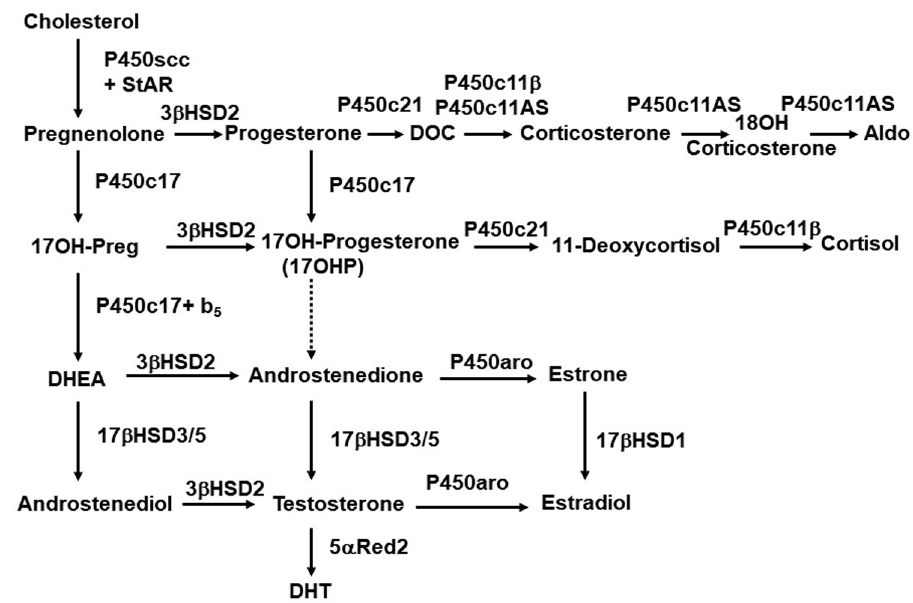
Fig 1. The “conventional” pathway of steroidogenesis. The figure combines adrenal and gonadal pathways. The left- hand column shows the Δ 5 pathway, in which steroids retain the double bond between carbons 5 and 6 in cholesterol’s B-ring. The StAR protein facilitates import of cholesterol into mitochondrial, in which P450scc (CYP11A1) cleaves off the side-chain to yield Preg, the first C21 steroid. Δ 5 steroids are converted to corresponding Δ 4 steroids by 3 β HSD2 (HSD3B2) in the adrenal and gonad or by 3 β HSD1 in placenta and peripheral tissues. In the absence of P450c17 (in the adrenal zona glomerulosa), progesterone is 21-hydroxylated by P450c21 (CYP21A2). P450c11AS (Aldo synthase, CYP11B2) then catalyzes 11-hydroxylase, 18-hydroxylase, and 18-methyl oxidase activities to yield Aldo. In the gonads and adrenal zona fasciculata, the 17 α -hydroxylase activity of P450c17 (CYP17A1) permits synthesis of 17OHP, which is 11-hydroxylated to cortisol by P450c11 β (CYP11B1). The 17,20 lyase activity of P450c17 requires allosteric action of cytochrome b5 (b5) in the adrenal zona reticularis and testicular Leydig cells, permitting conversion of C21 to C19 steroids. Human P450c17 converts 17OHP to androstenedione with only approximately 2–3% of its activity to convert 17OH-Preg to DHEA so that testosterone synthesis proceeds via DHEA and not via 17OHP; by contrast, rodent and ungulate P450c17 catalyzes this reaction efficiently. Testicular 17 β HSD3 converts DHEA to androstenediol and androstenedione to testosterone; low levels of adrenal 17 β HSD5 (AKR1C3) permit synthesis of small amounts of testosterone. In the ovary and elsewhere, P450aro (aromatase, CYP19A1) converts C19 androgens to C18 estrogens. In genital skin, 5 α -reductase type 2 (5 α Red2, SRD5A2) further activates testosterone to DHT. 17OHP, 17OH- progesterone; Aldo, aldosterone; C21, 21-carbon; DHEA, dehydroepiandrosterone; DHT, dihydrotestosterone; Preg, pregnenolone; StAR, steroidogenic acute regulatory